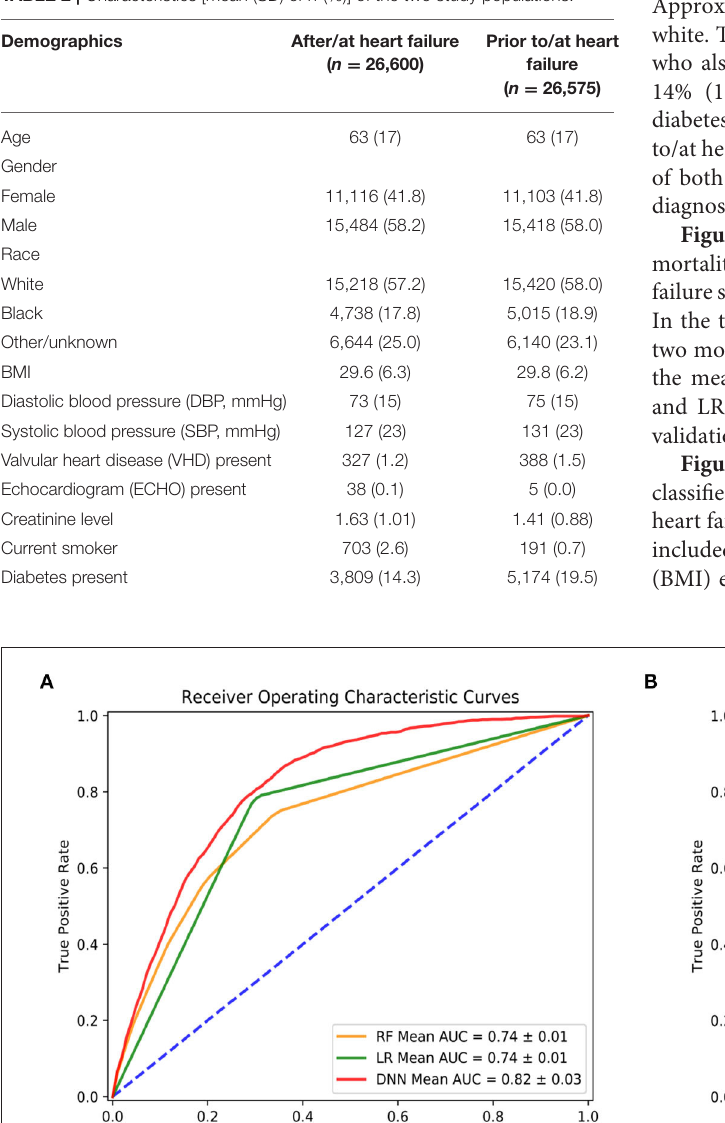
Frontiers in Digital Health |